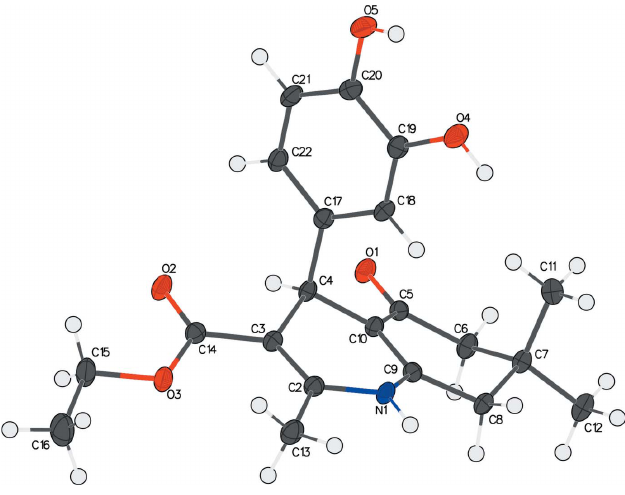
Figure 3 The asymmetric unit of compound III showing the atom-labeling scheme. Displacement ellipsoids are drawn at the 50% probability level.